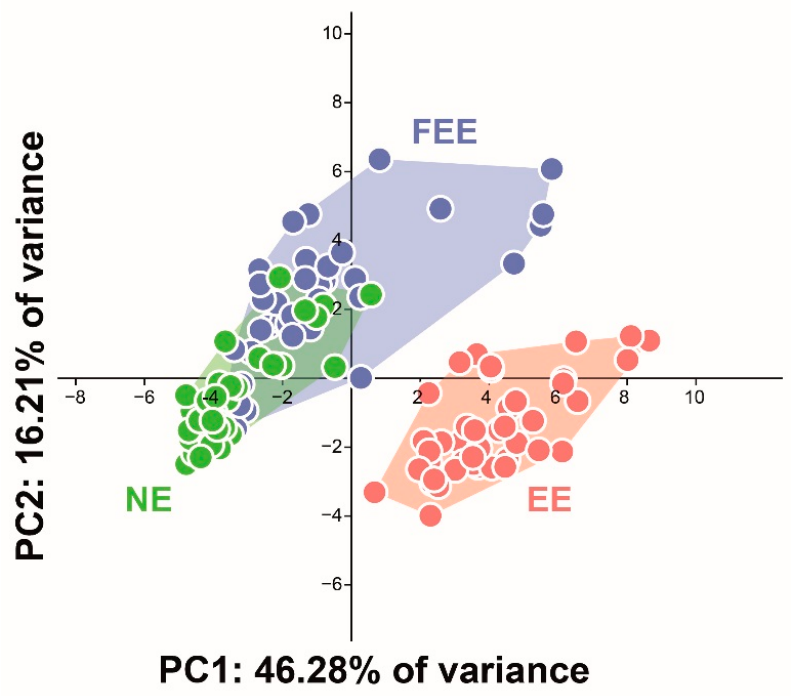
Figure 1. Principal component analysis (PCA): Graphic presentation of the overall differences between the groups, taking into account the contribution of all 30 parameters (NE is designated in green, EE in red, FEE blue).